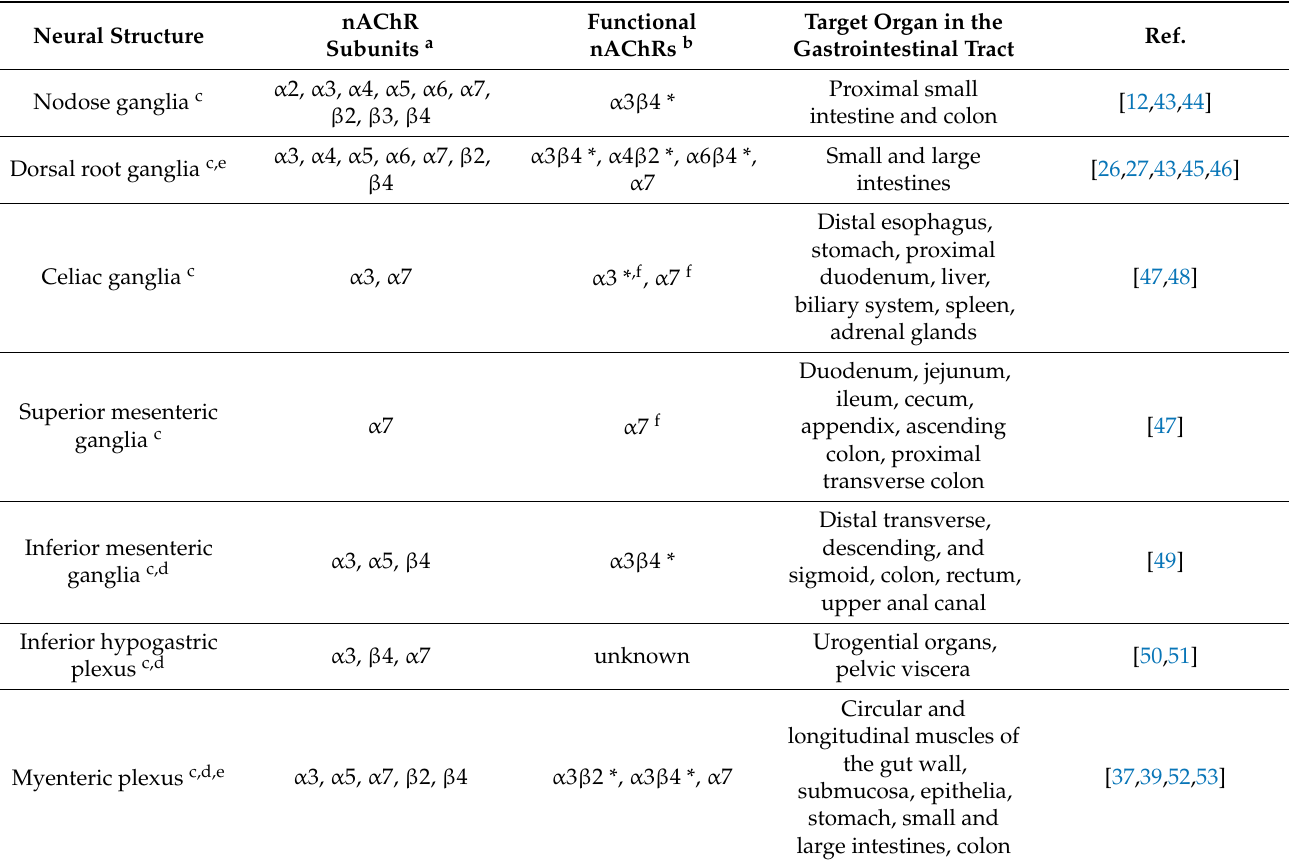
a Subunits detected by molecular biology techniques; b nAChR subtypes detected by functional assays; c rodent; d guinea pig; e human; f probable functional expression; * denotes the potential presence of other